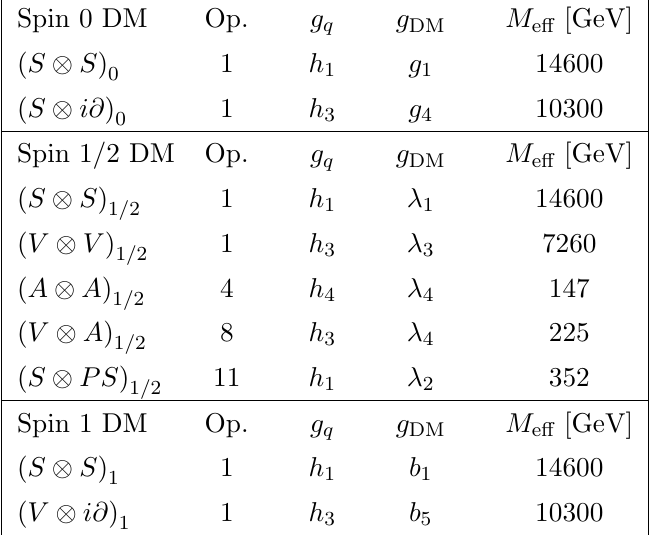
Table 3 . Benchmark points producing 150 signal events in an idealised version of XENONnT for m (cid:31) = 50 GeV [28]. Consistently with [28], in the case of spin 1 DM we do not consider the contribution to M e(cid:11) from e(cid:11)ective operators that depend on the symmetric combination of polarisation vectors denoted by S . We omitted models that are not compatible with a dijet signal in the relevant parameter